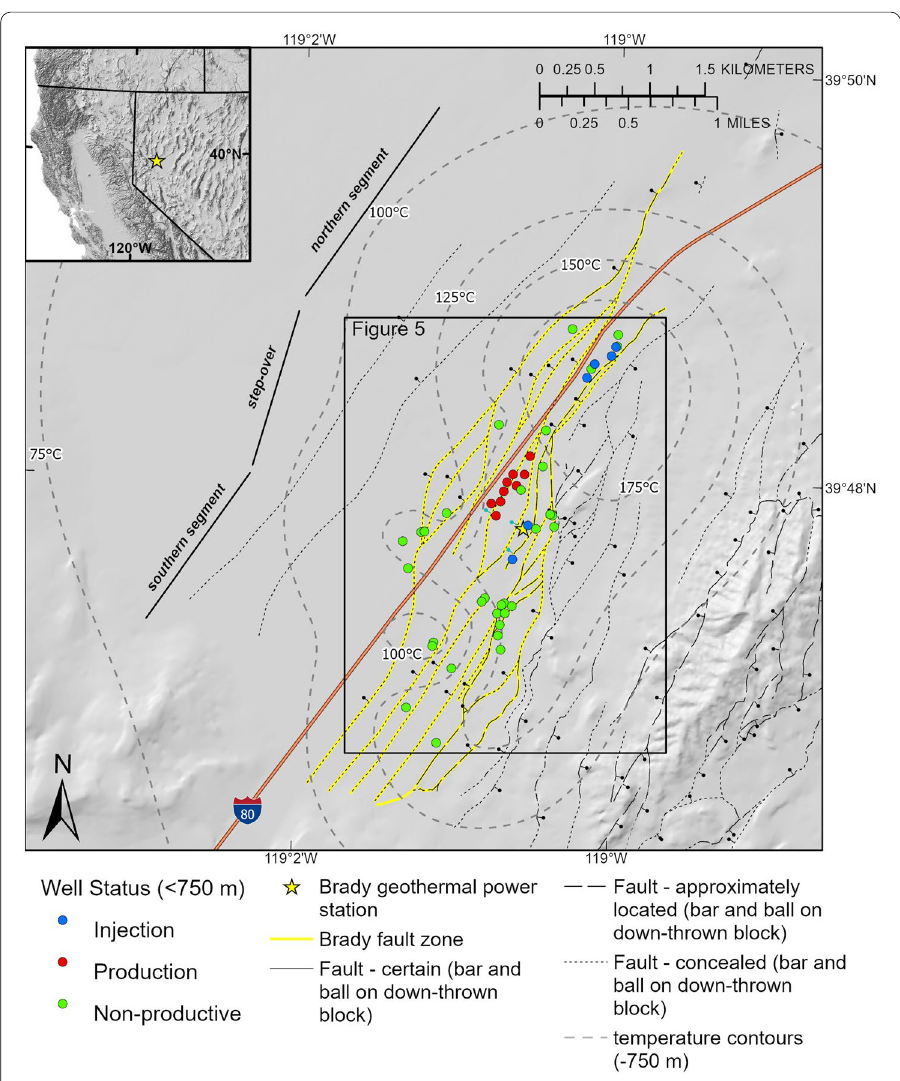
Fig. 1 Map of Brady geothermal area. The fault strands that constitute the Brady fault (data from Faulds et al. 2017) are shown in yellow. Contours represent modeled temperature, a linear interpolation of the temperature data at 750 m depth. These are the same data as the modeltemp variable. Wells are colored by their usage (production, injection, and non-productive) for depths shallower than 750 m. The general geometry of the step-over is shown to the left of the fault system. Interstate 80 (orange line) is shown for